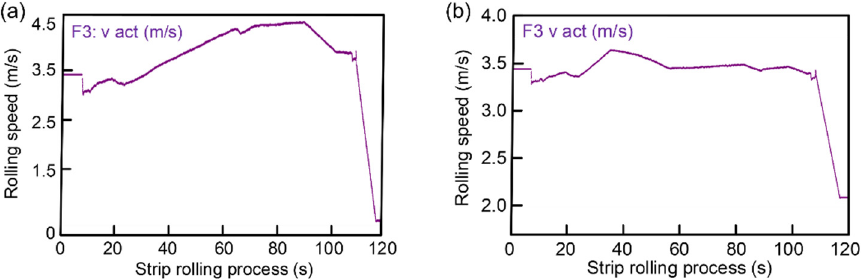
Figure 8. The change in rolling speed: ( a ) 1.6 mm and ( b ) 3.2 mm.